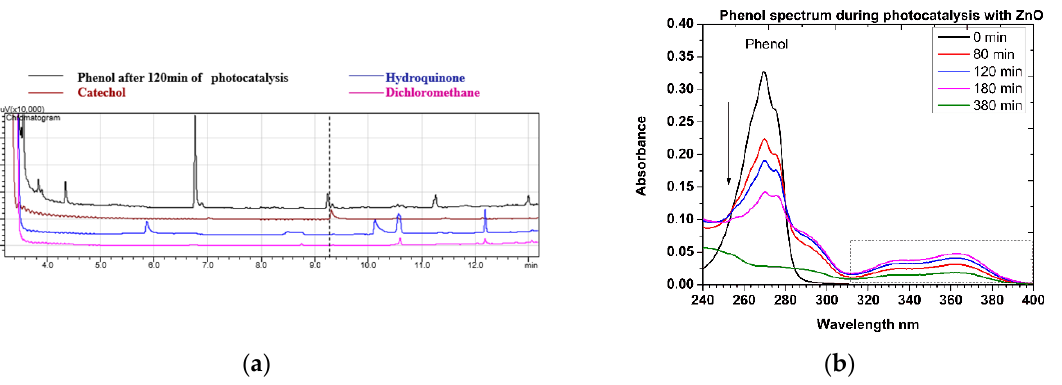
Figure 12. ( a ) GC-FID chromatogram of phenol degradation products extracted in dichloromethane, after 120 min of photocatalytic reaction as compared with the corresponding ones of catechol, hydroquinone, and dichloromethane (solvent). ( b ) Spectrum of the UV-Vis absorbance of phenol degradation products as a function of time.